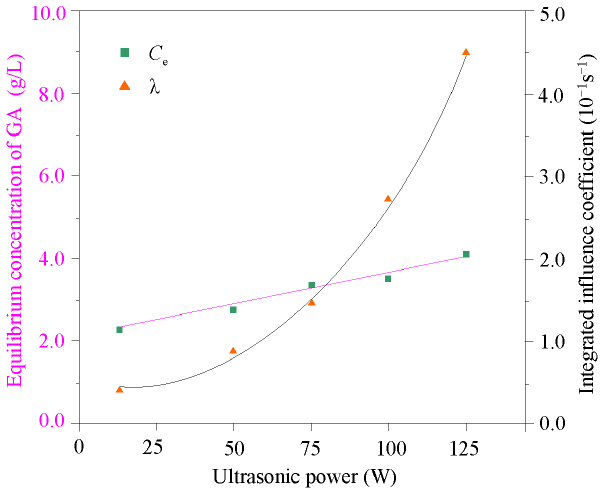
Figure 5. The equilibrium concentration ( C e ) of glycyrrhizic acid, and integrated influence coefficient ( λ ) with different ultrasonic powers.